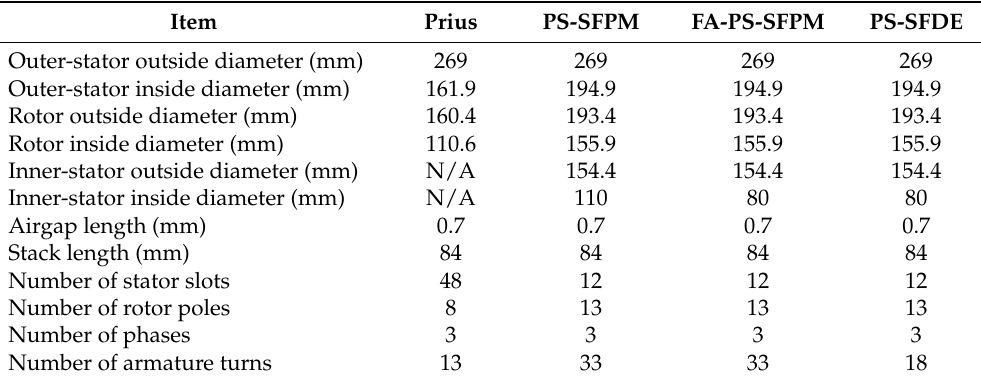
Table 1. Major Machine Parameters, machine dimensions are reproduced from [19].